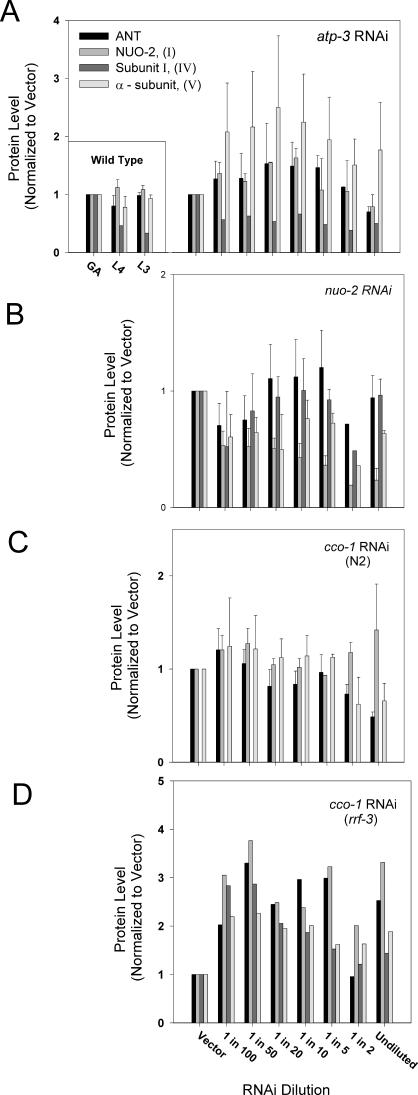
Compensatory Responses at the Level of the Mitochondrial ETCRNAi dilution series for atp-3 (A), nuo-2 (B), and cco-1 (C and D) were established using wild-type (N2 [A–C]) or rrf-3(pk1426) mutant (D) animals (target gene to empty vector ratio: 0:1, 1:100, 1:50, 1:20, 1:10, 1:5, 1:2, and 1:0). Samples were grown until adulthood (except animals treated with undiluted atp-3 RNAi, which remained arrested as L3 larvae), then harvested as first-day adults. Levels of four mitochondrial proteins (ANT, NUO-2 [complex I], subunit I of complex IV, and the α-subunit of complex V) were measured in whole-worm extracts using western analysis. Untreated, wild-type animals cultured on OP50 E. coli were harvested as third or fourth stage larvae (L3 and L4, respectively) as well as first-day gravid adults (GA) and then similarly subjected to western analysis ([A], inset). Differences in sample loading within each experiment were normalized against actin. Each experiment was then further normalized against the respective vector-only treatment (or relative to GA in the case of OP50-fed N2). Data in each panel represent the mean (±SEM) of at least two independent experiments (except [D], which represents a single experiment).